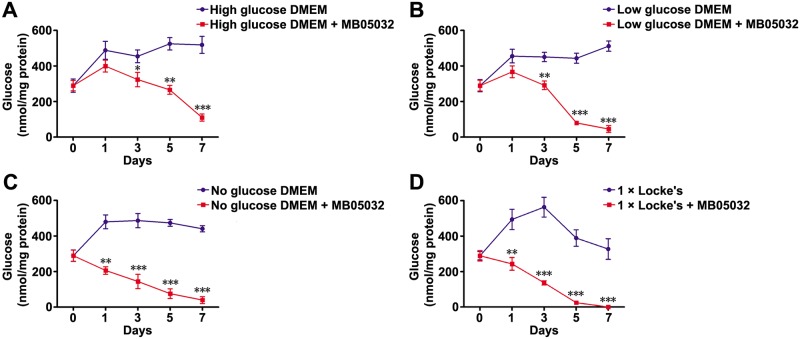
Glucose level inside C. sinensis adults with or without MB05032 treatment.Adult flukes were respectively maintained on high, low, and no glucose DMEM (A, B, and C), as well as 1 × Locke’s (D) with or without the addition of MB05032. Glucose level was detected at 0, 1, 3, 5, and 7 d of feeding. Differences between two groups were evaluated by student’s t test. *P < 0.05, **P < 0.01, and ***P < 0.001 were represented as statistical significance.